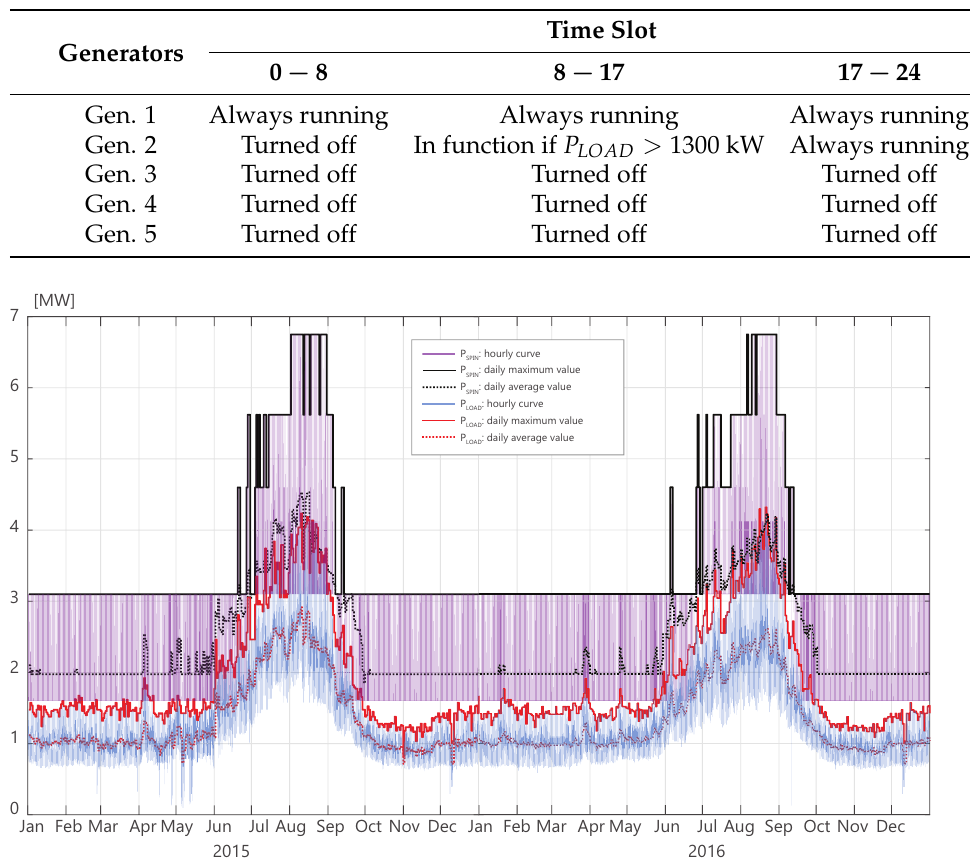
Table 3. Control logic of diesel groups for the rest of the year.